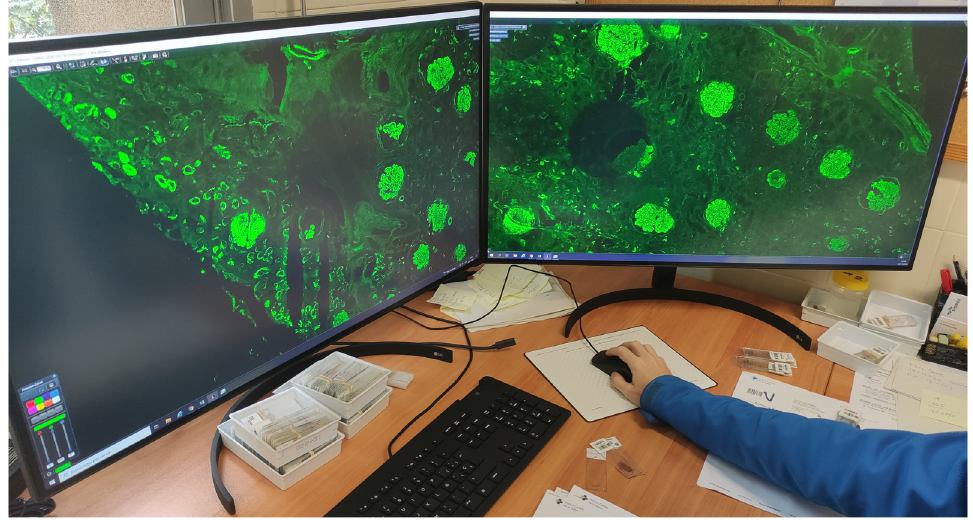
Figure 10. Fluorescence seen in a totally integrated fashion on two 32-inch LG 32HL512D 8MP di- agnostic